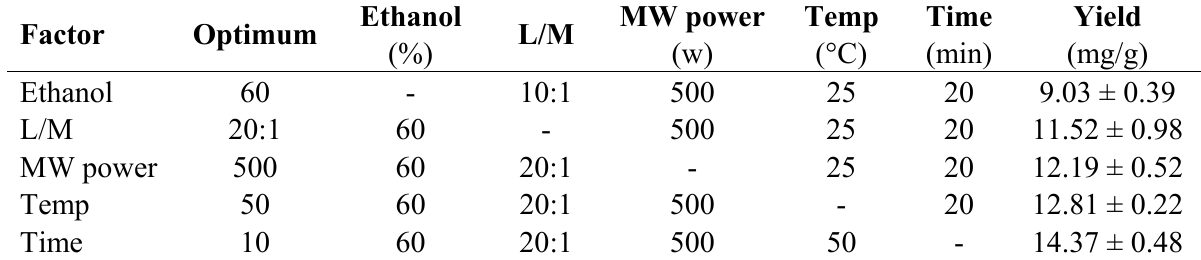
Table 1. Effects of experimental parameters on extraction yield of oxymatrine.